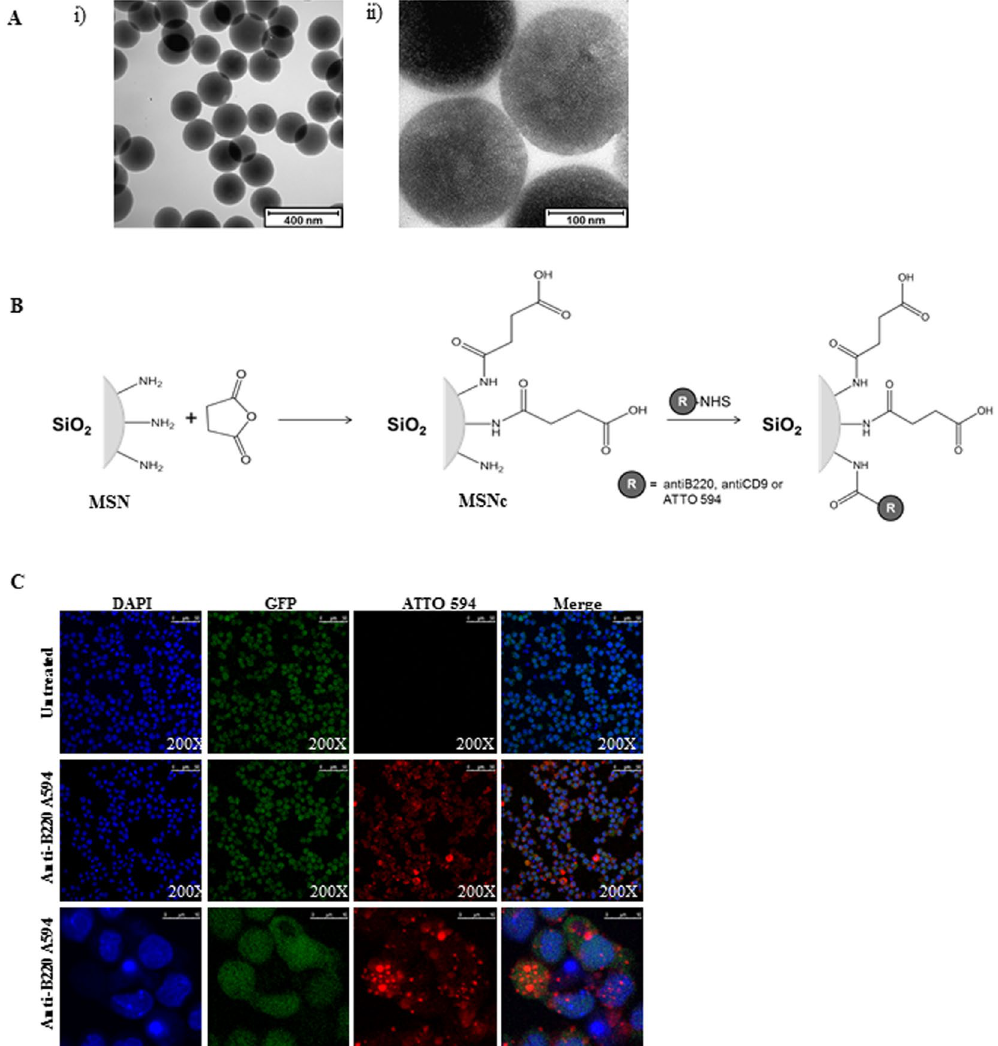
Figure 1. ( A ) Transmission electron microscopy images of MSN. Characterization of particles size and (i) morphology and (ii) analysis of pore structure. Scale bar is given. ( B ) Scheme of particle functionalization with succinic anhydride, antibody (anti-human/mouse-B220 (CD45R) or anti-human-CD9) and fluorescent dye (ATTO 594). ( C ) B220 + AML LSCs (CALM-AF10 cells) were treated with the anti-B220 tagged MSNs particles for 24 hours and spotted on glass slides and were visualized by confocal fluorescence microscopy. Nuclei were stained with DAPI (Blue), GFP (Green) is expressed retrovirally by the cells line and ATTO 594 (Red) was covalently linked to the MSNs. One representative image from three (n = 3) independently performed experiments. Particle concentration used is 50 µ g/mL. For the upper and middle panel of images a magnification of 200X was used. The lower panel shows 4X zoomed in areas of the middle